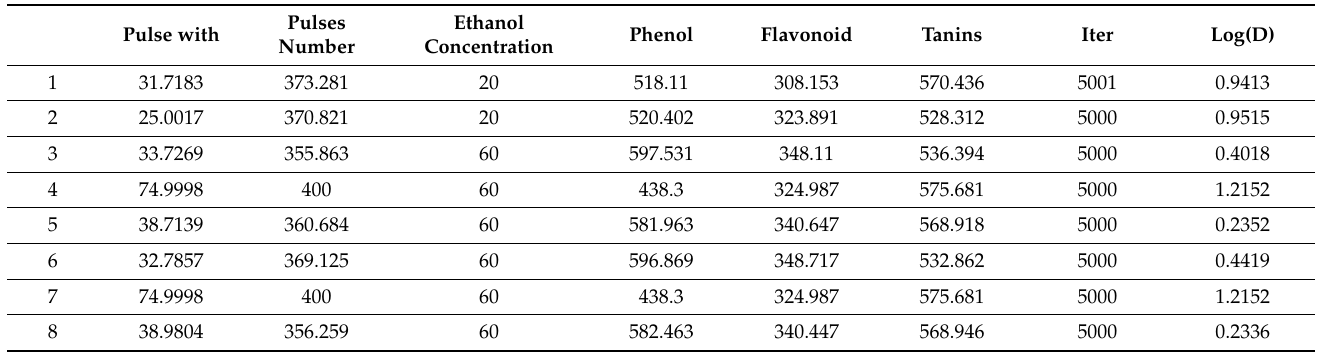
Table 3. Results of the optimisation routine.